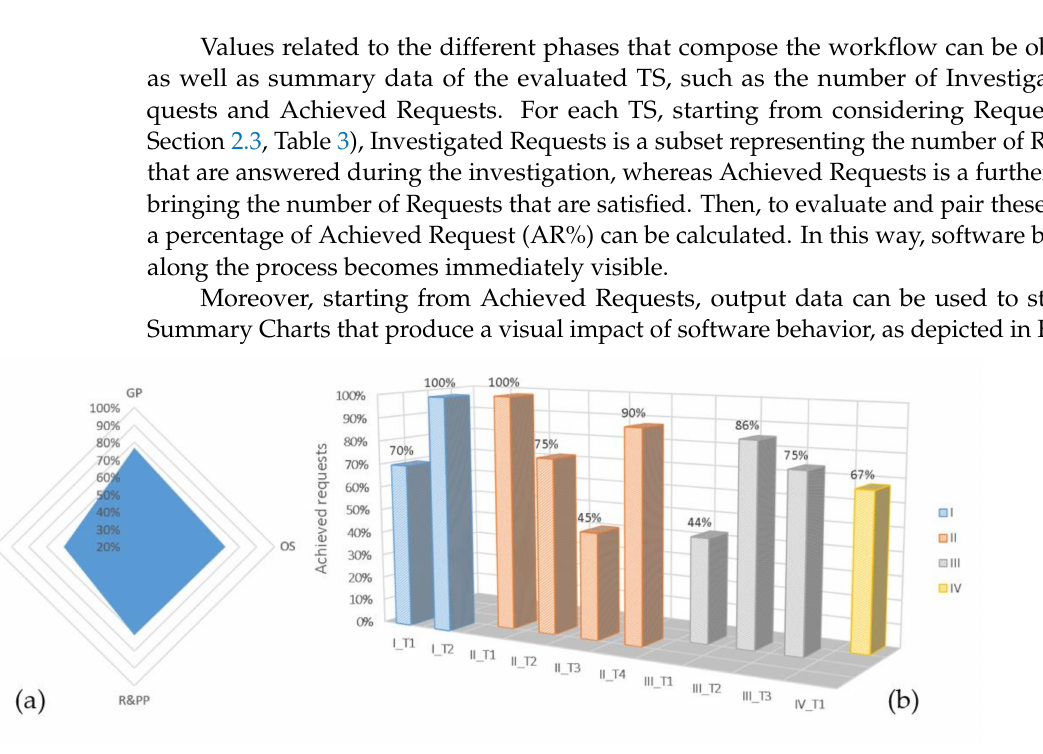
Figure 8. On the left side, the Phase-focused Summary Chart ( a ); on the right side, the Task-focused Summary Chart ( b ) for a generic